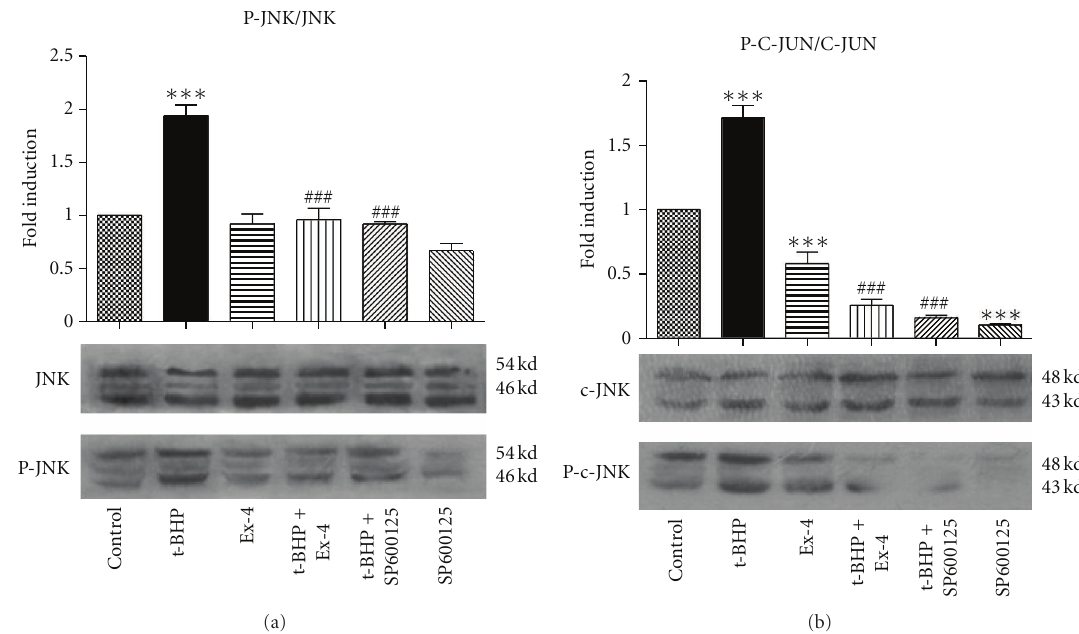
Figure 4: Exendin-4 inhibits t-BHP-induced aptosis via JNK signaling pathway . MIN6 cells were preincubated with exendin-4 (100nM) or with SP600125 (10nM) for 18h and then exposed to t-BHP (25 μ M) for 1h. Representative western blot images revealed the expression levels of phospho-JNK and total JNK protein (a); phospho-c-JUN and total c-JUN (b). The histogram shows the quantification of the protein data. Levels of phosphorylated protein were normalized to the levels of total protein and expressed as the relative fold change compared to the control samples. Values correspond to the mean ± SD ( n = 3). ∗∗∗ P < 0 . 001 compared with the control group; ### P < 0 . 001 versus t-BHP